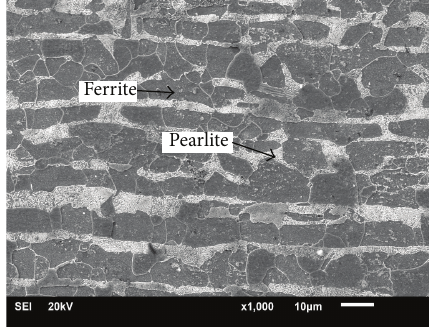
Figure 5: Microstructure of as-received material ASTM A516 grade 70.